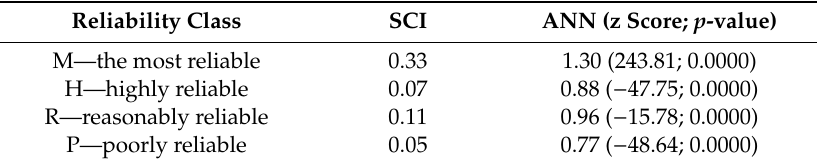
Table 5. Spatial pattern of LS reliability